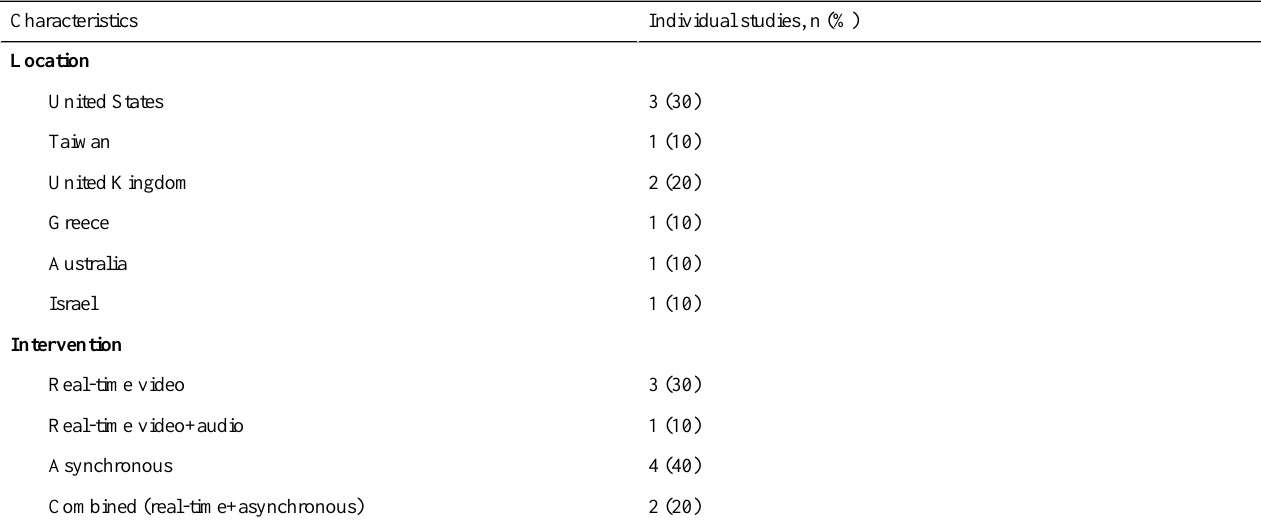
Table 2. Baseline characteristics of the individual studies (n=10, without systematic reviews and